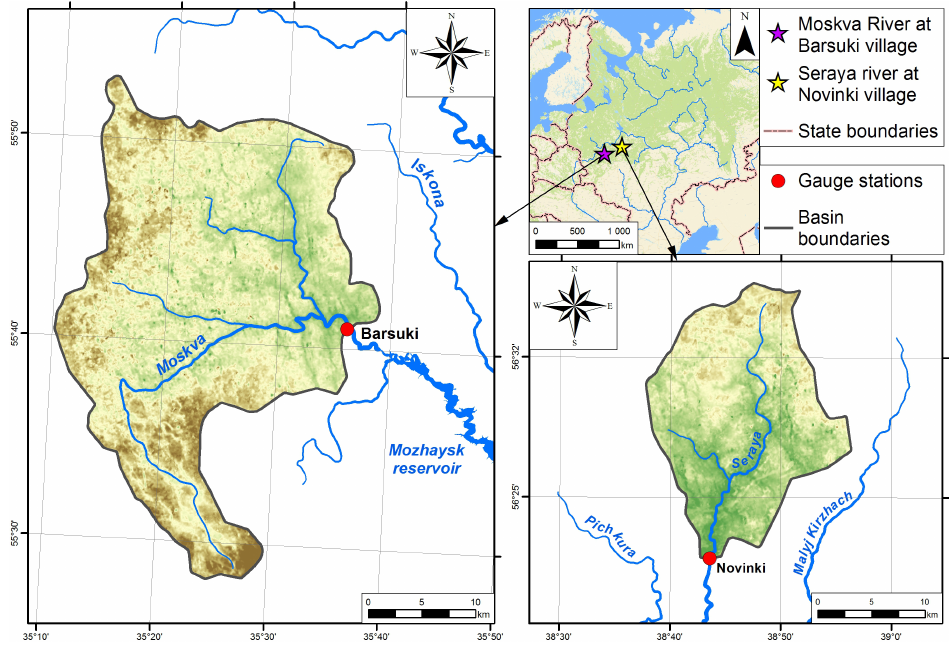
Figure 1. Study area and pilot